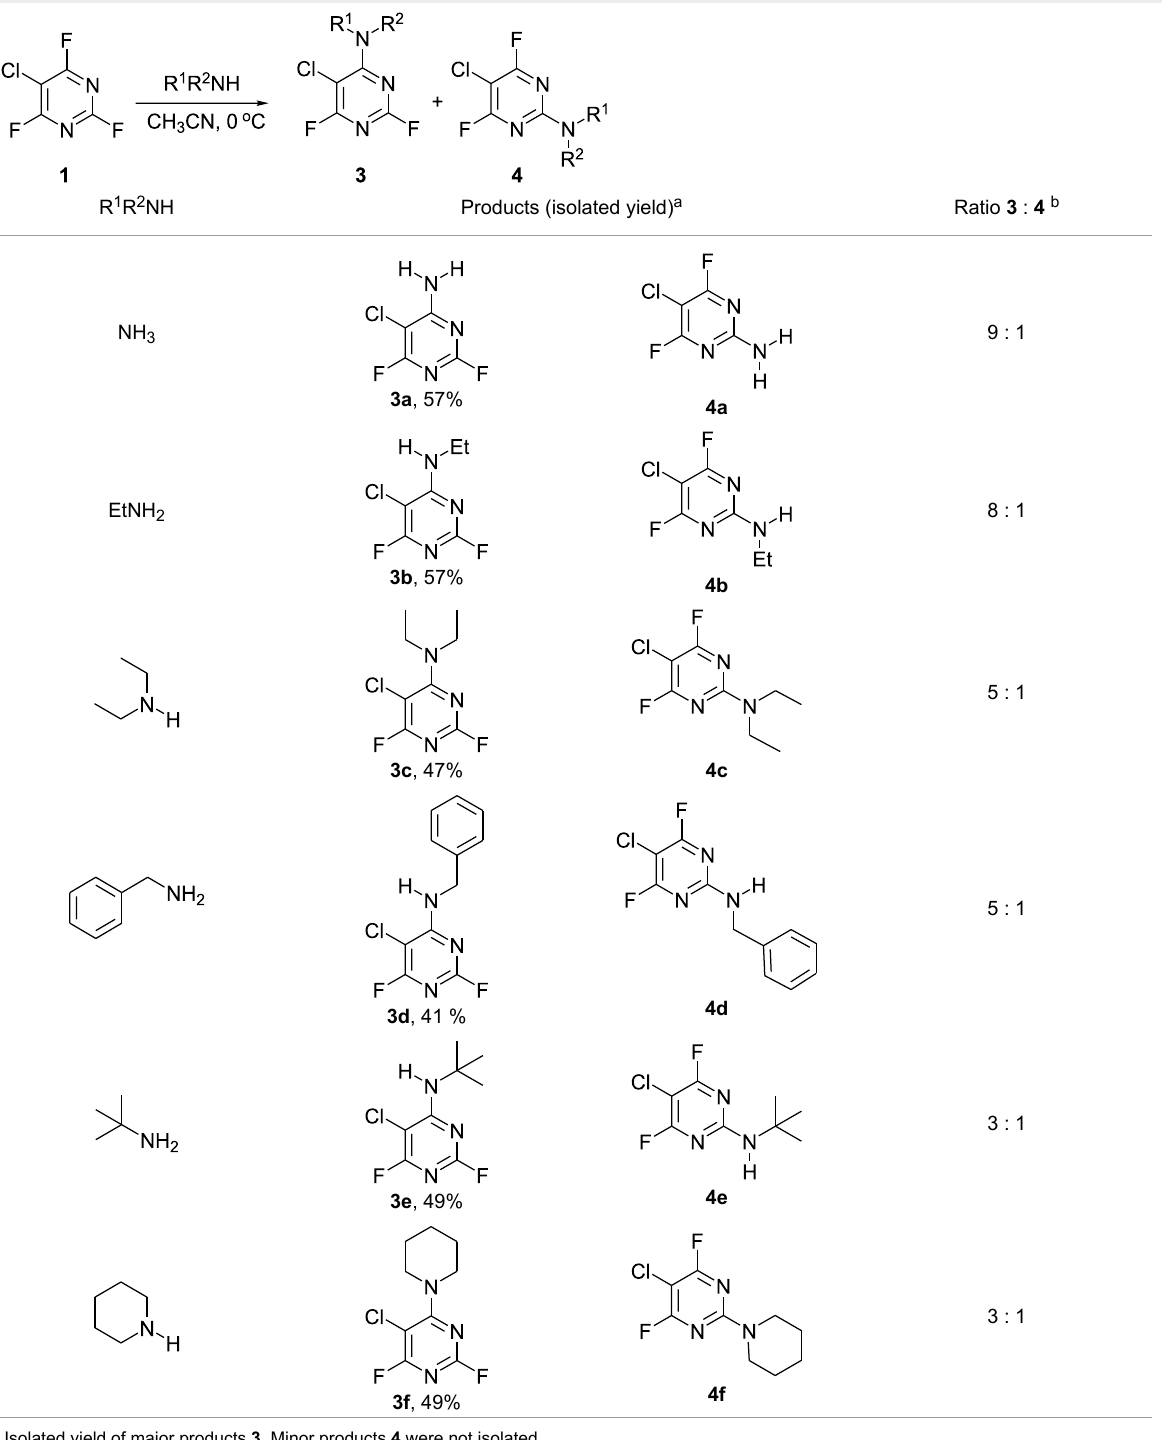
Table 1: Reactions of amine nucleophiles with 5-chloro-2,4,6-trifluoropyrimidine ( 1